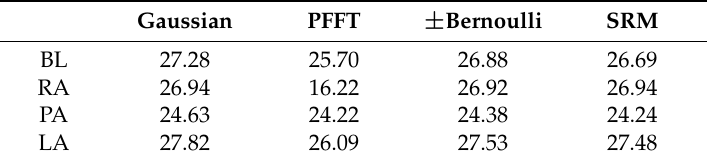
Table 5. Average PSNR values (dB) for different structures using different measurement